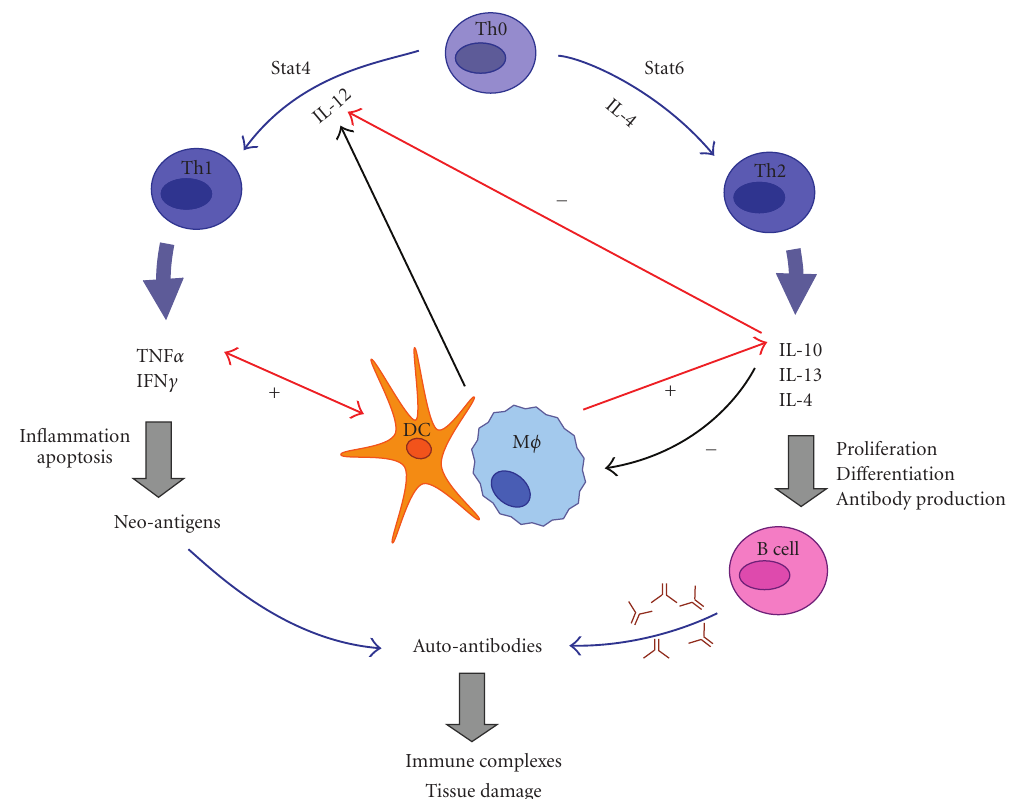
Figure 1: Interplay between IL-10 and TNF α in SLE . This figure represents a simplified model of the complex relationship between IL-10 and TNF α in lupus disease. Both cytokines are produced by multiple cells types of the innate and adaptative immune system, in particular dendritic cells (DCs), monocytes/macrophages, and specific e ff ector T cells. Th1 cells produce the proinflammatory cytokine TNF α which activates DCs and other antigen presenting cells (APCs), and induces the production of IL-10. In addition, TNF α promotes inflammation and apoptosis, generating neoantigens that could result in autoantibody production. On the other hand, IL-10, a Th2 cytokine, antagonize Th1 di ff erentiation and inhibits APCs and T cells. Conversely, IL-10 is a potent stimulator of B cell proliferation, di ff erentiation and antibody production. Thus, B cell activation in presence of neo-antigens may led to autoantibody secretion and immune complexes formation, thus resulting in tissue damage a ff ecting diverse organs. STAT; signal transducer and activator of